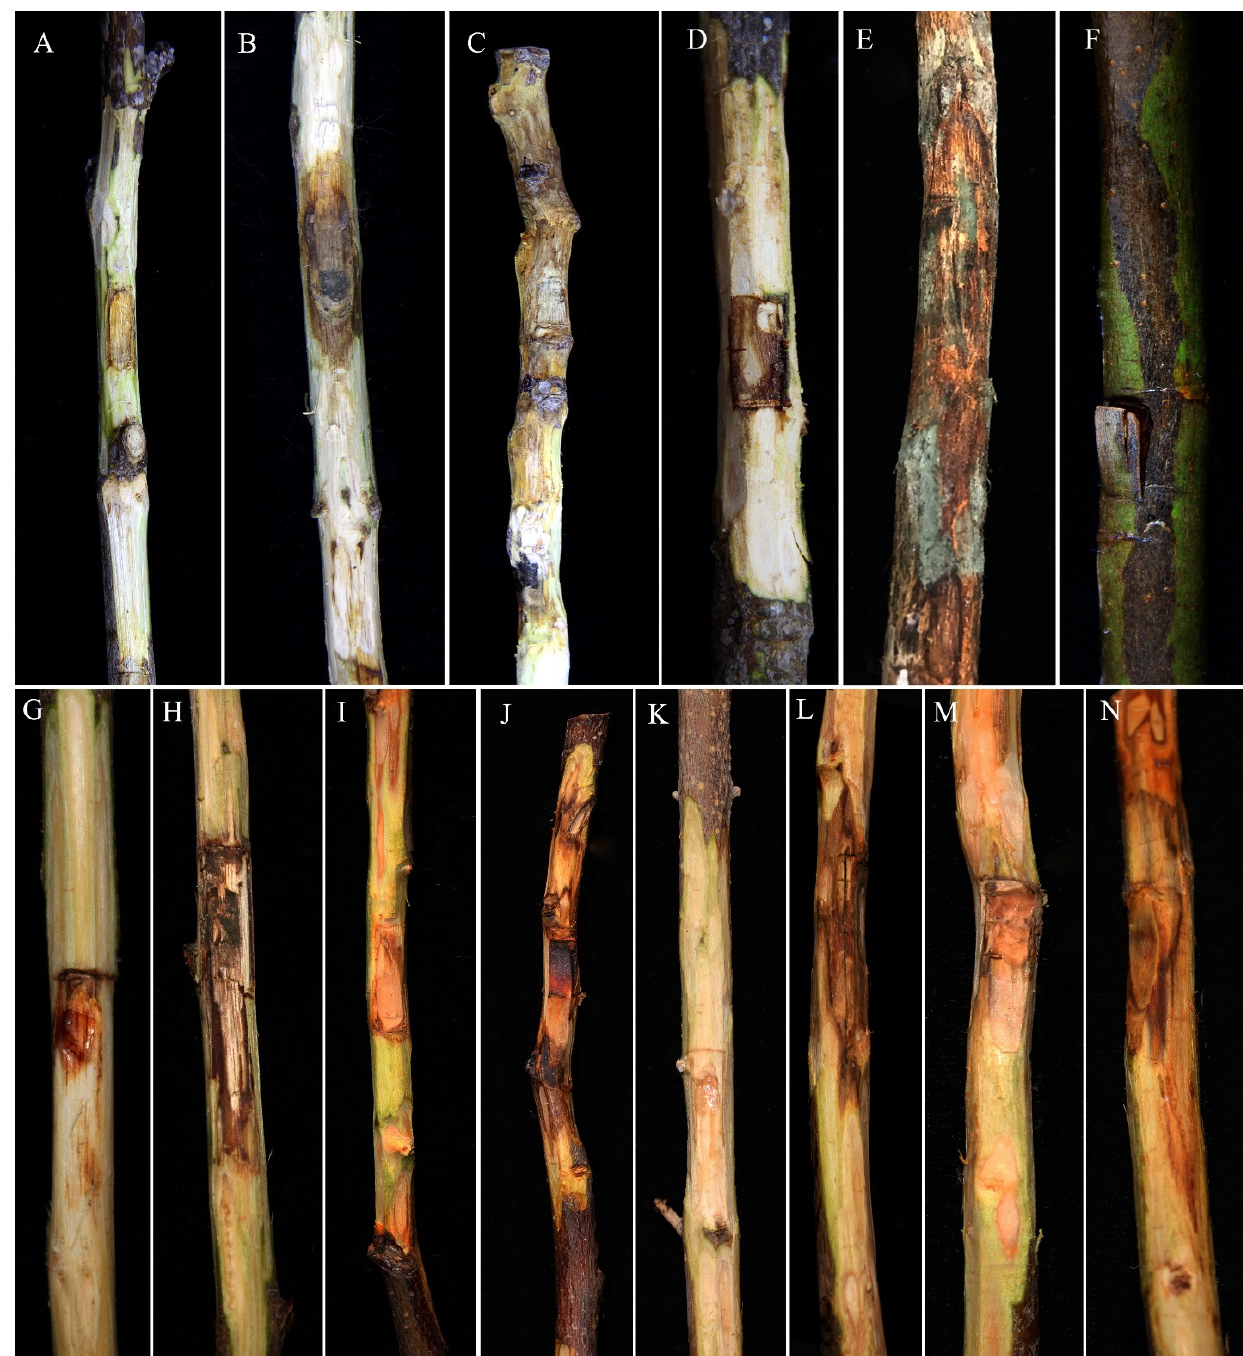
Figure 8. Lesions induced by Stilbocrea banihashemiana sp. nov. artificially inoculated on detached stems of fig, loquat, and other fruit trees compared with controls 21 days after inoculation. ( A ): Healthy Ficus carica cv. Sabz control, ( B ): Infected F. carica cv. Sabz; ( C ): Infected F. carica cv. Siah; ( D ): Healthy loquat; ( E ): infected loquat; ( F ): One side discoloration on infected loquat; ( G ): Healthy